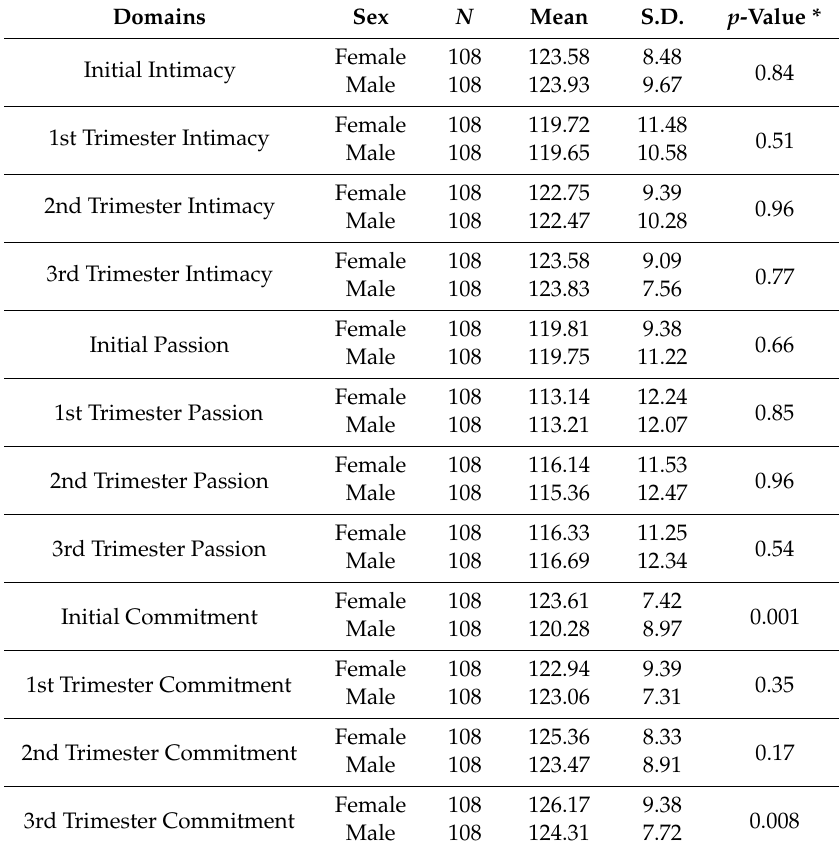
Table 6. Comparison by sex of the test domain scores and the total scores.